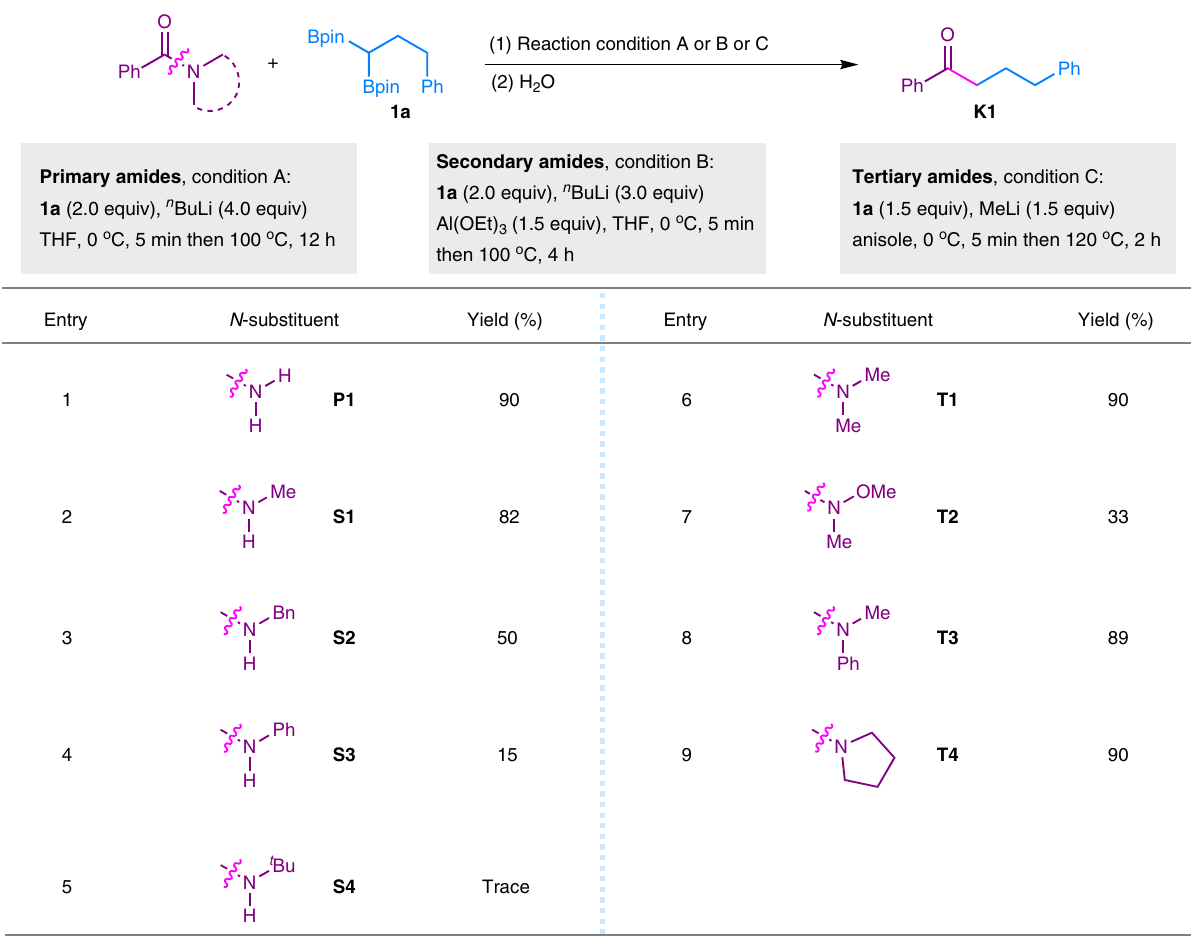
Fig. 2 Reactivity study of different amides. Condition A (primary amides): 1a (0.50 mmol), P (0.25 mmol), n BuLi (1.0 mmol), THF (2.0 mL), 0 °C, 5 min then 100 °C for 12 h. Condition B (secondary aides): 1a (0.50 mmol), S (0.25 mmol), n BuLi (0.75 mmol), Al(OEt) 3 (0.375 mmol), THF (2.0 mL), 0 °C, 5 min then 100 °C for 4 h. Condition C (tertiary amides): 1a (0.375 mmol), T (0.25 mmol), MeLi (0.375 mmol), anisole (2.0 mL), 0 °C, 5 min then 120 °C for 2 h. Yields were determined by GC analysis using naphthalene as an internal standard. THF: